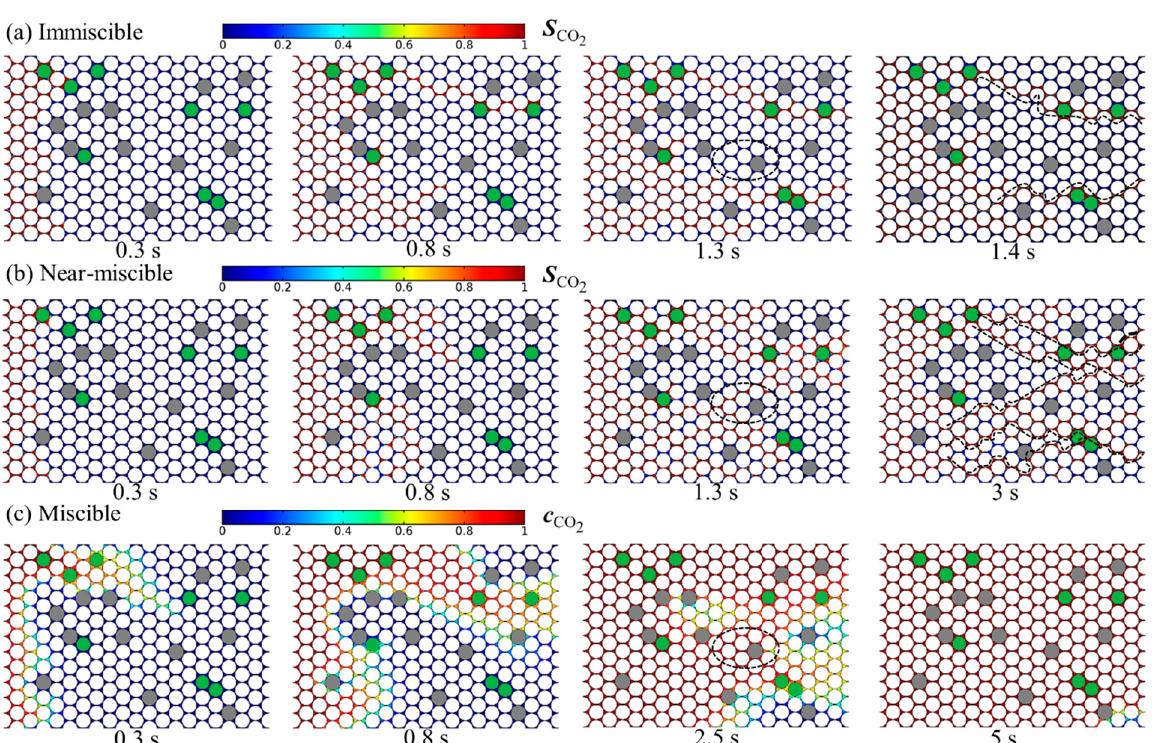
Figure 4. Temporal evolution of the calculated CO 2 saturation distribution under ( a ) immiscible and ( b ) near-miscible conditions as well as the calculated CO 2 concentration distribution under ( c ) the miscible condition. The dotted line marks the CO 2 finger path; the dotted ellipse indicates the increased CO 2 sweep area under the near-miscible condition compare to the immiscible condition.